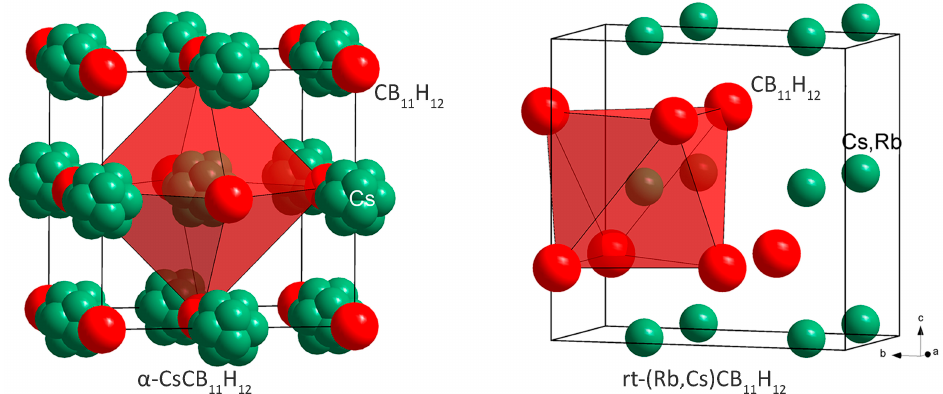
Figure 2. Structural representations of α -CsCB 11 H 12 with anions ccp , and of mixed cation phase rt -(Rb,Cs)CB 11 H 12 with anions hcp. The CB 11 H 12 − anions are simplified as red